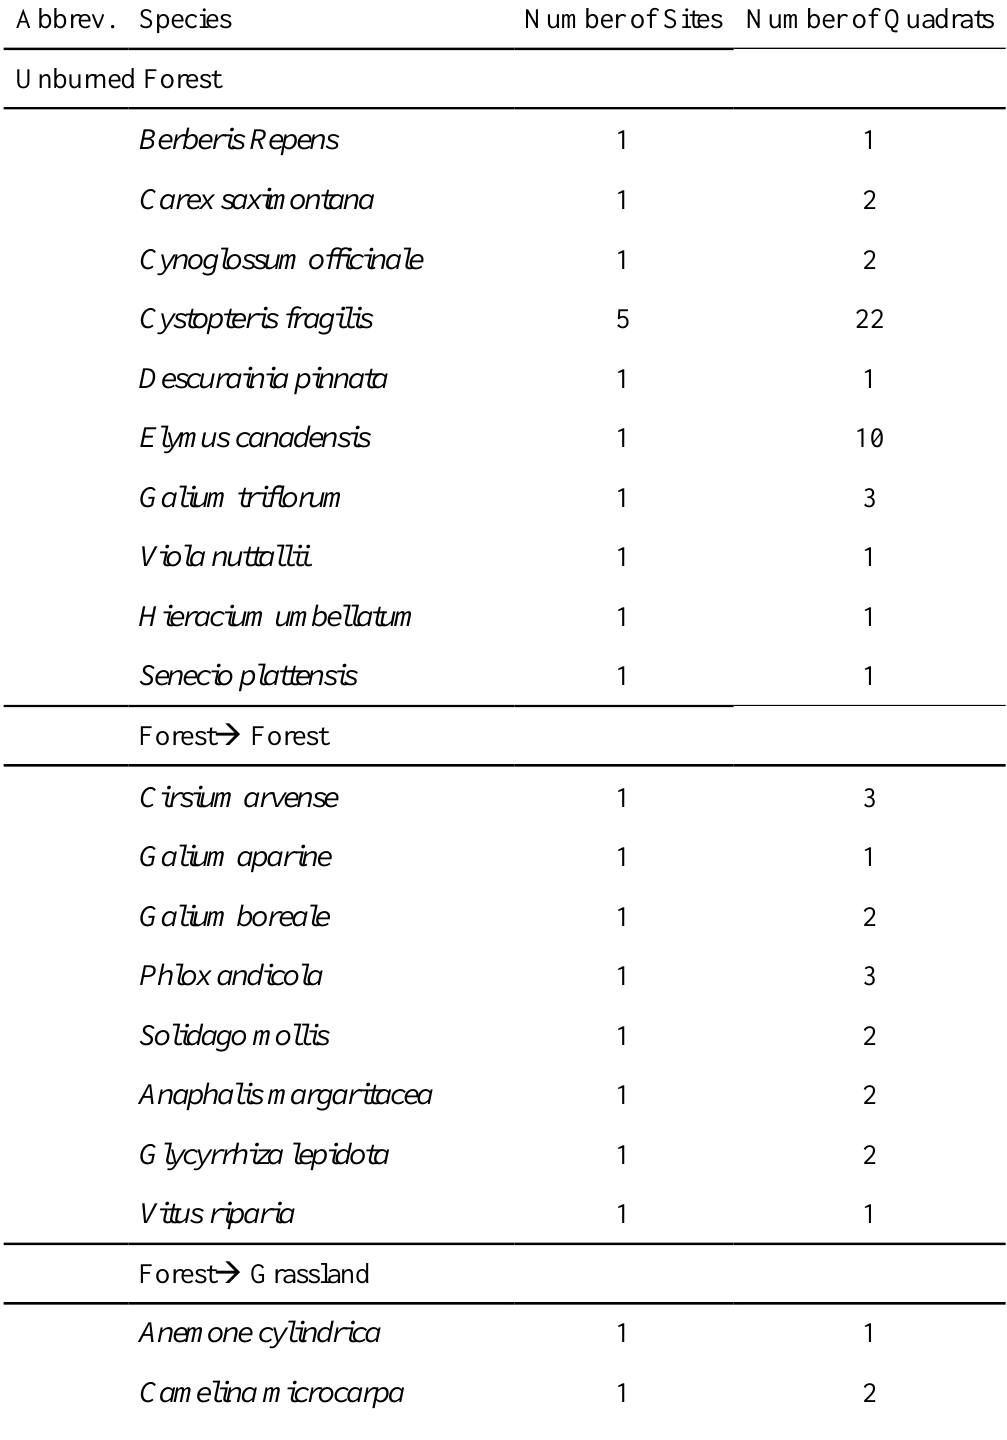
Table A1.5. A list of herbaceous species that were unique to each transition class, along with the number of sampling site and number of quadrats that each species was recorded in.